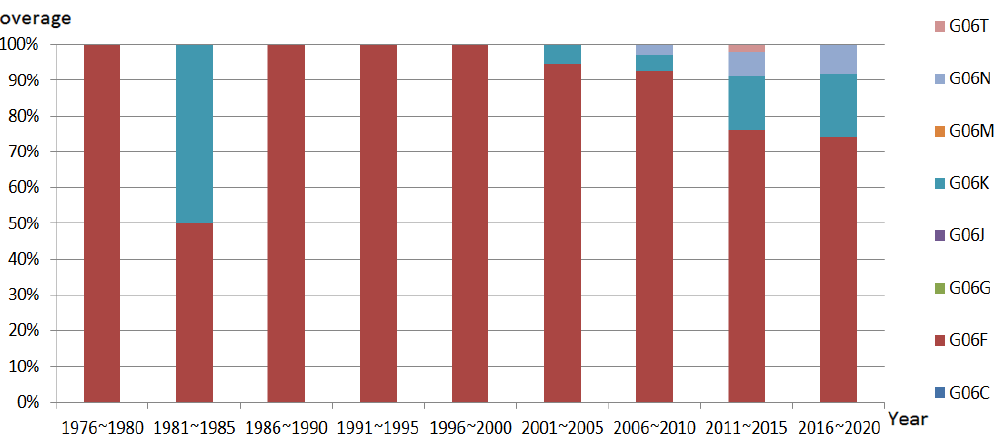
Figure 3. CPC sub-classification affecting accounting information systems ’ patents by year.